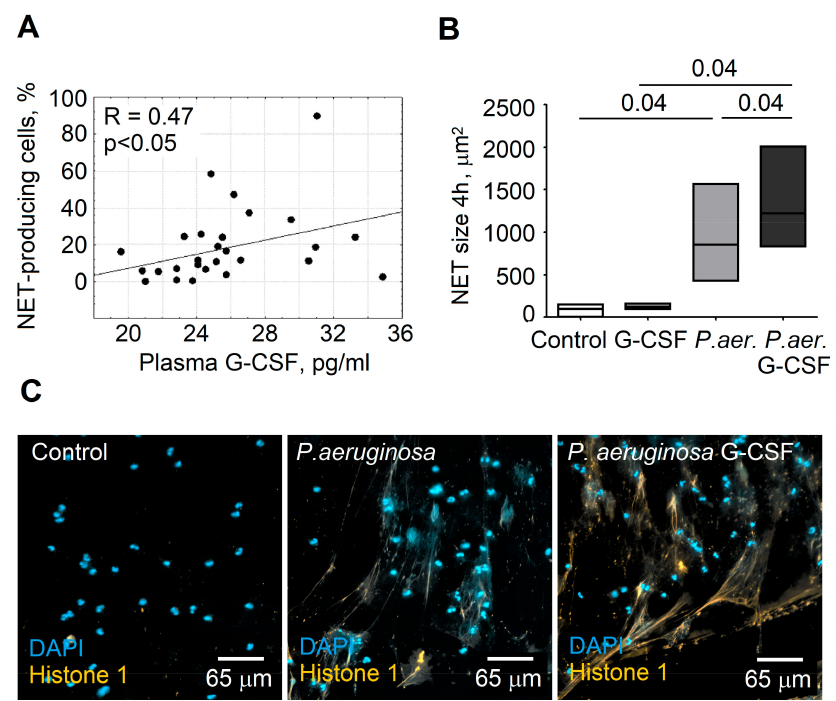
Figure 4. G-CSF stimulates P. aeruginosa -induced NET formation. ( A ) Plasma G-CSF levels correlate with the percentage of early (within the first hour of co-incubation with P. aeruginosa ) NETs. For analysis of correlations, Spearman’s R test was used. ( B ) P. aeruginosa -induced NET formation of healthy donor ( n = 5) neutrophils can be stimulated with G-CSF in vitro. Data are shown as median and min / max. For comparisons of two dependent groups, a Wilcoxon matched-pairs signed rank test was used. ( C ) Representative figures illustrating the stimulation of P. aeruginosa -induced NET formation by G-CSF. DAPI (blue), histone 1 (orange), scale bar 65 µ